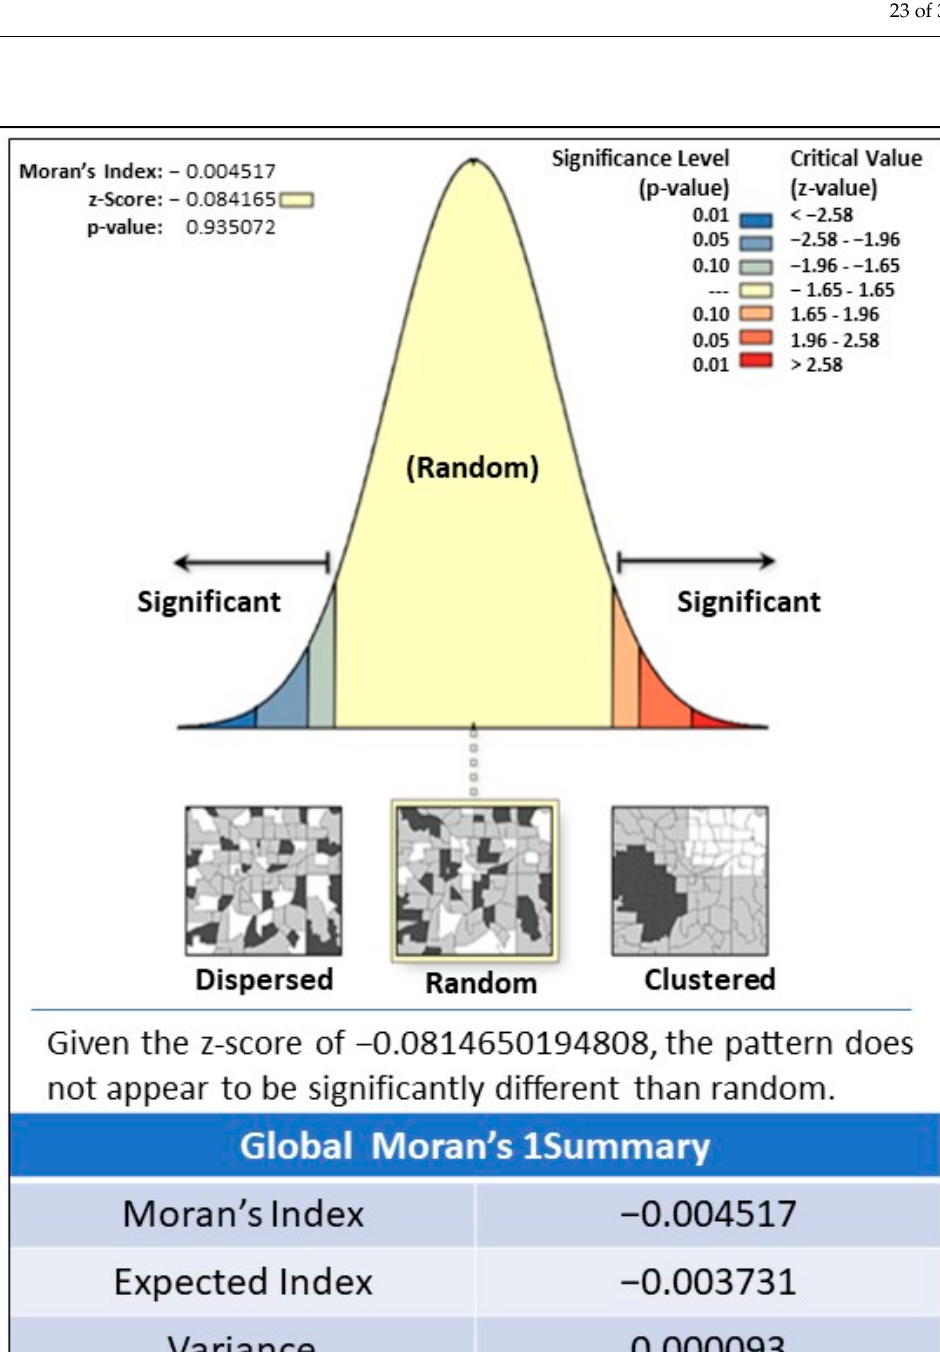
Figure 12. Spatial Autocorrelation report of the fire events.